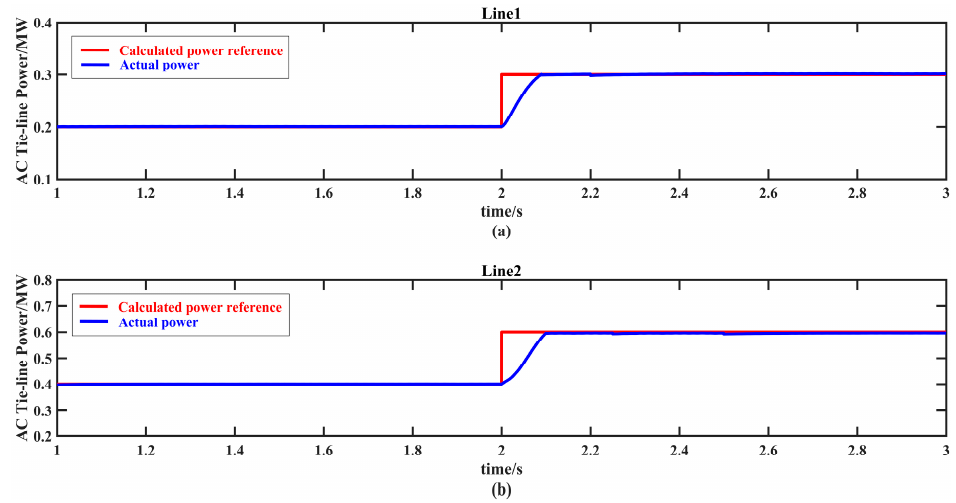
Figure 10. Actual AC tie-line power during the “limited condition” of the SMES. ( a ) AC tie-line 1; ( b ) AC tie-line 2.